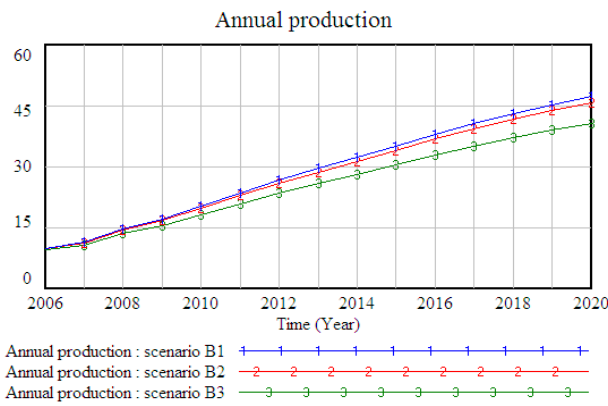
Figure 7. Annual added proved reserves (billion cubic meters).